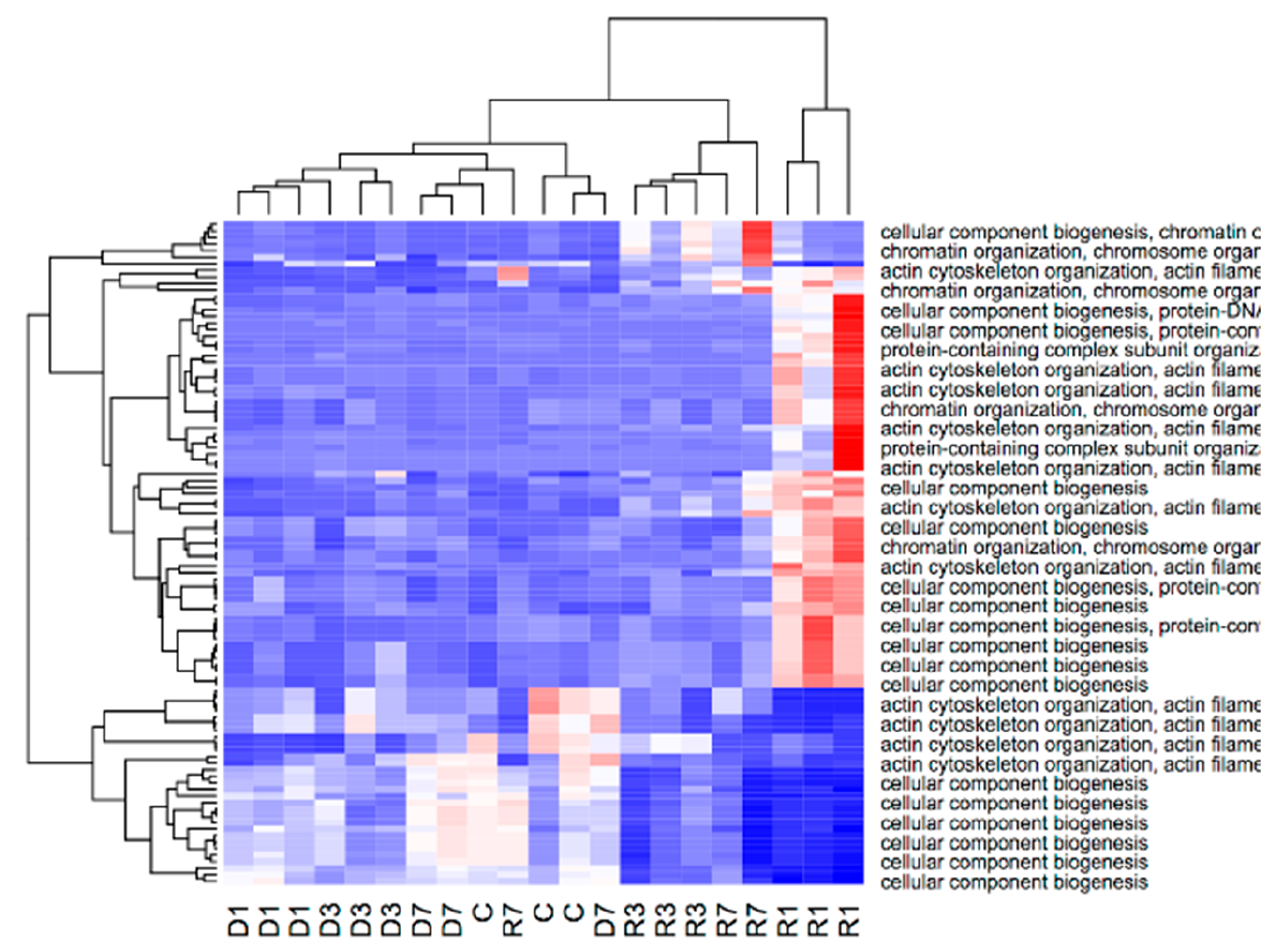
Figure 4. Non-genic peaks annotated with GO biological process of DEGs, which are located upstream (see Supplementary Figure S2 for full figure). Samples names attribute to Dx—days of disuse, and Rx—recovery. In total, more than a half (1263 × 100/2246 = 56.23%) of the TSSs were associated with regions upstream of DEGs in slow muscle, and less than a half (210 × 100/474 = 44.30%) were region-associated TSSs in fast muscle, located upstream of a given DEG, which showed significant co-expression with that gene in the cycle of disuse—recovery (see Supplementary Table ST8, Figure